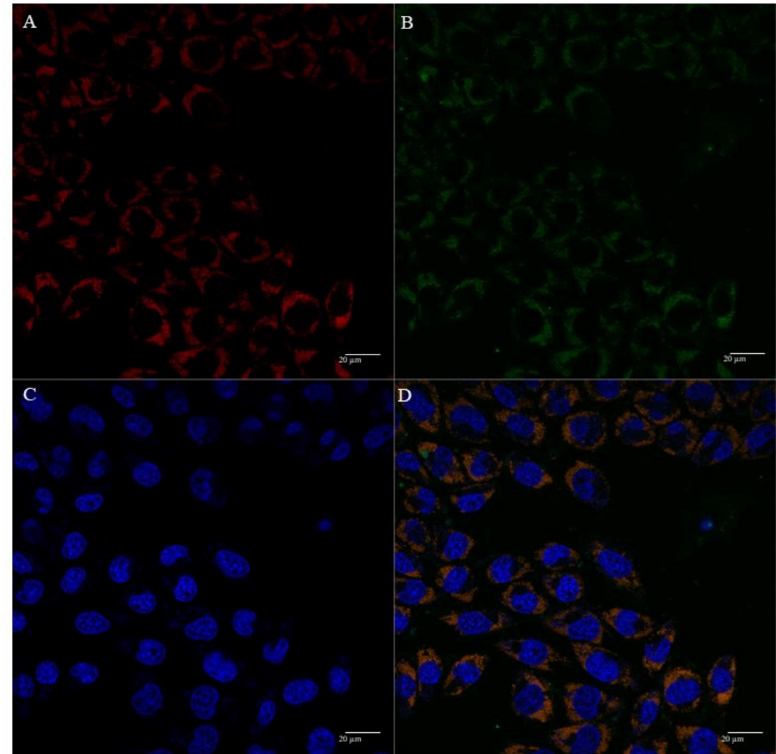
Figure 6. Representative confocal fluorescence image of HeLa cells illustrating the transfection ability and intracellular co-localization of CpMTP/pND1 complexes formulated at an N/P ratio of 5. Mitochondria stained red by MitoTracker ( A ), pND1 green, labeled ( B ), nucleus marked blue by DAPI ( C ), and merged image ( D ). Scale bar = 20 µ